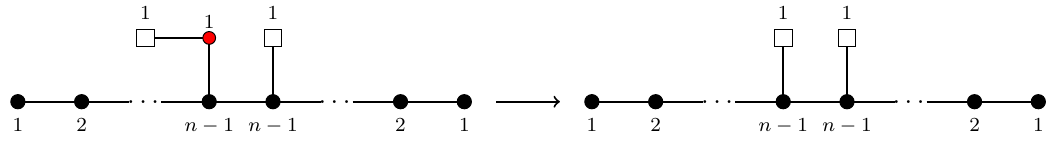
Figure 3 . The FI deformation on the red node leads to the quiver on the right-hand-side, which is the 3d mirror of U( n − 1) with N = 2 n − 1 f